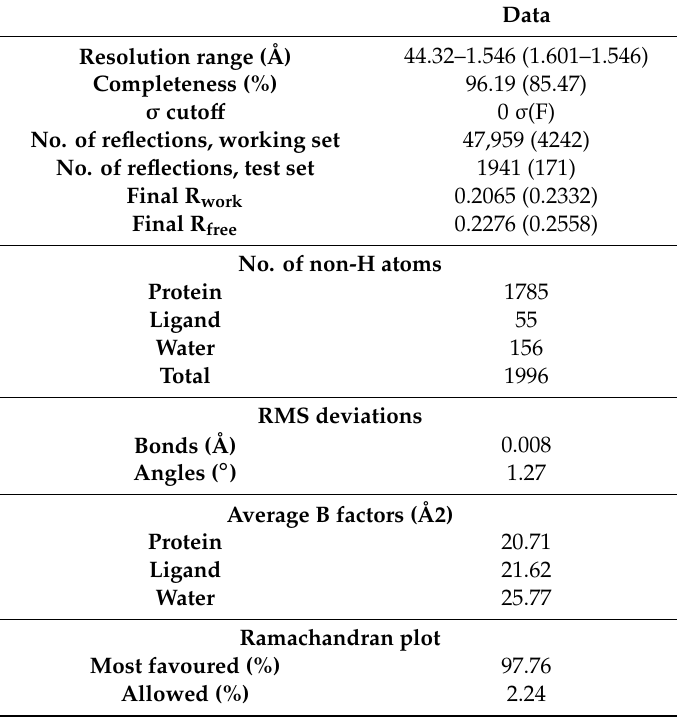
Table 3. Structure solution and